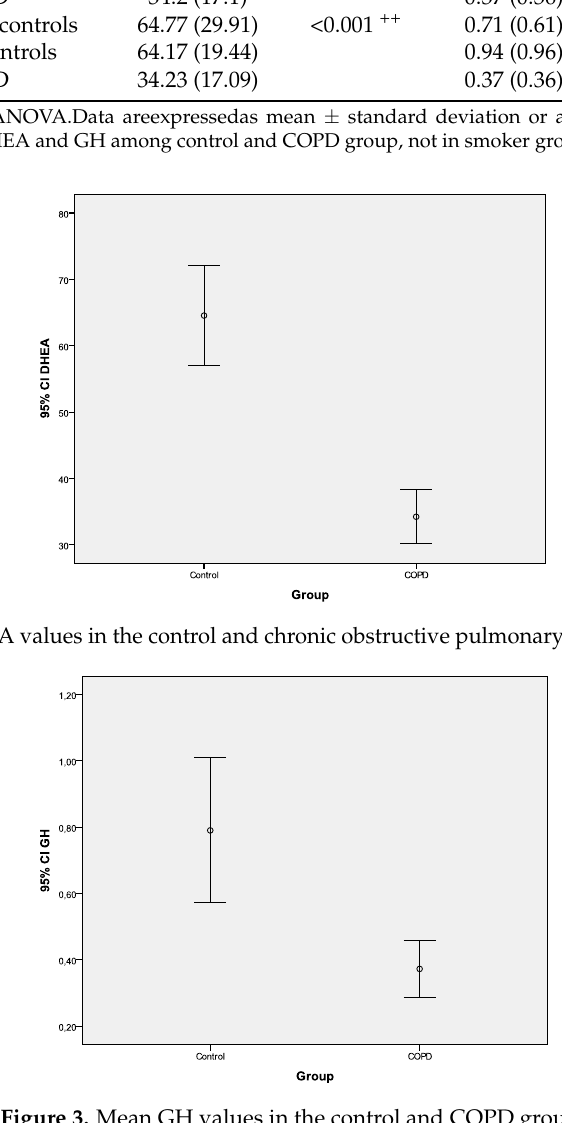
Table 2. Dehydroepiadrosterone(DHEA) and Growth Hormone (GH) levels in the study groups.